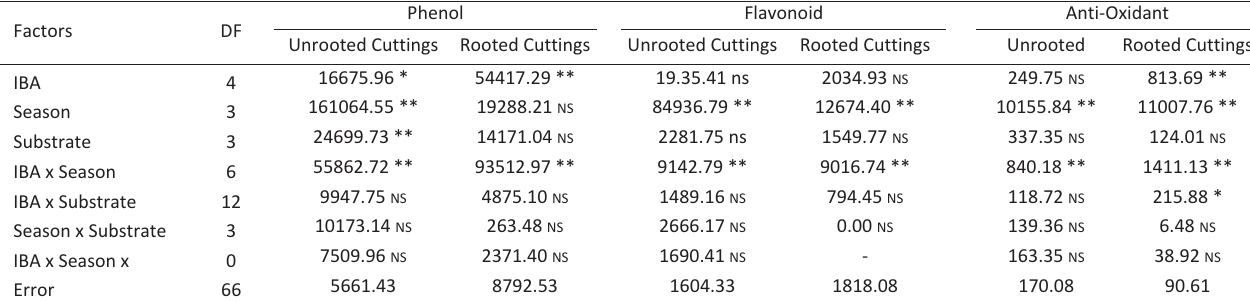
Fig. 7 ­ A, B, C The mean values of rooting performance in roo­ ted cuttings (root number) within for the 5 treatments of indole butyric acid, 4 season and 4 substrates. The mean values with the same letter were not different at level 0.05 according to the LSD test. Sample data: 540 cuttings for each substrate. Table 2 ­ Results of a multifactor ANOVA used to examine the effect of major factors on the secondary metabolite composition of stem cuttings over four